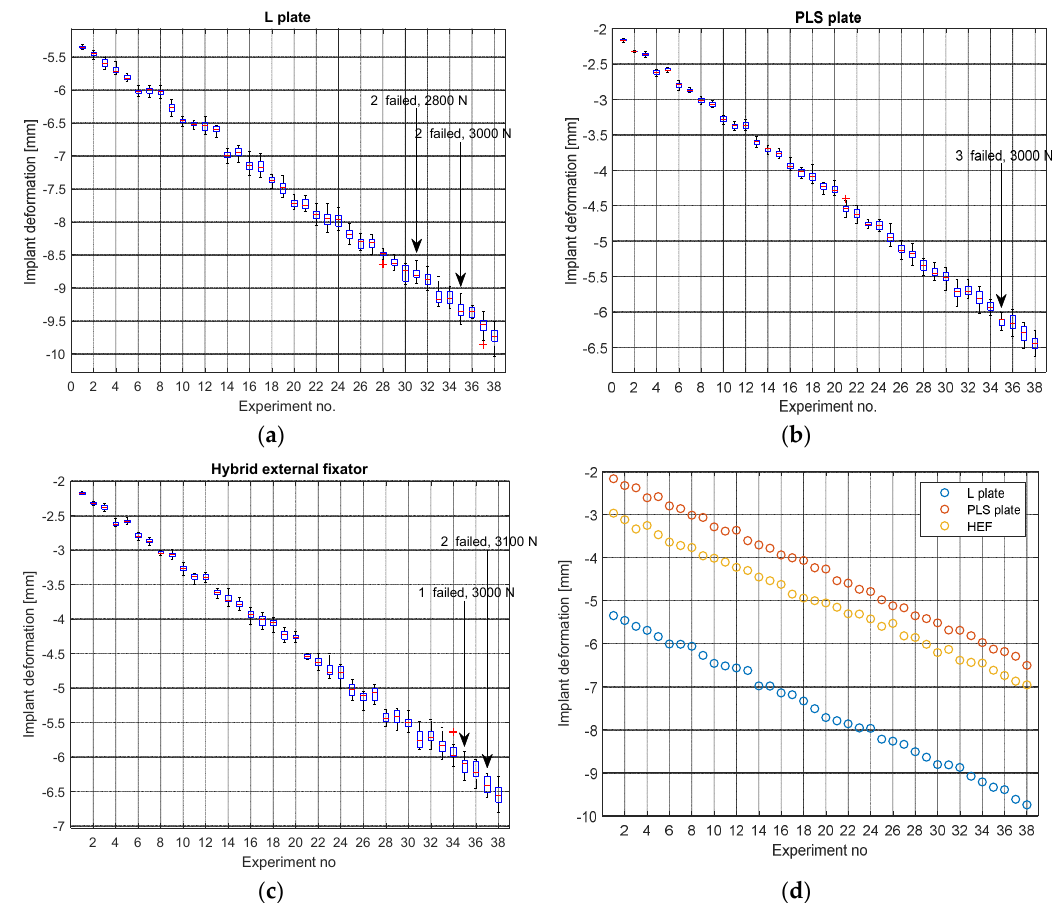
Figure 12. Box plots of raw data for each implant device type ( a – c ) and processed data ( d ).